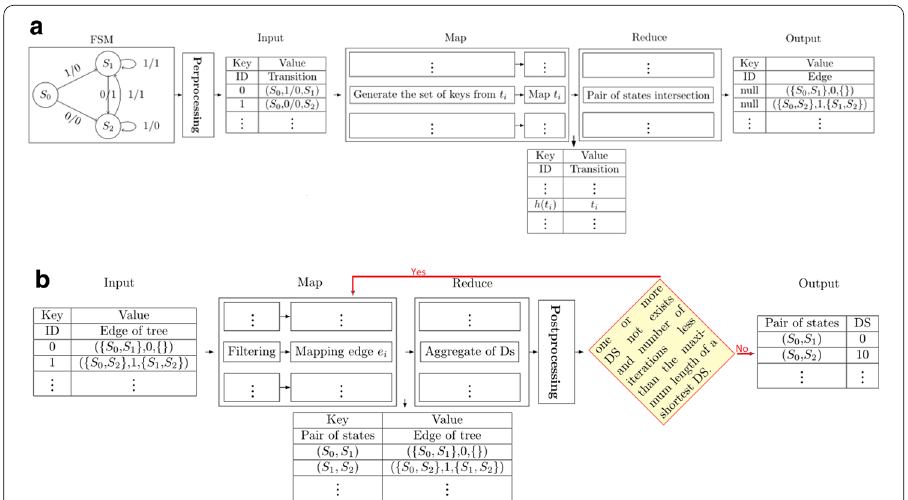
Fig. 3 An overview of the parallel Exact Algorithm using